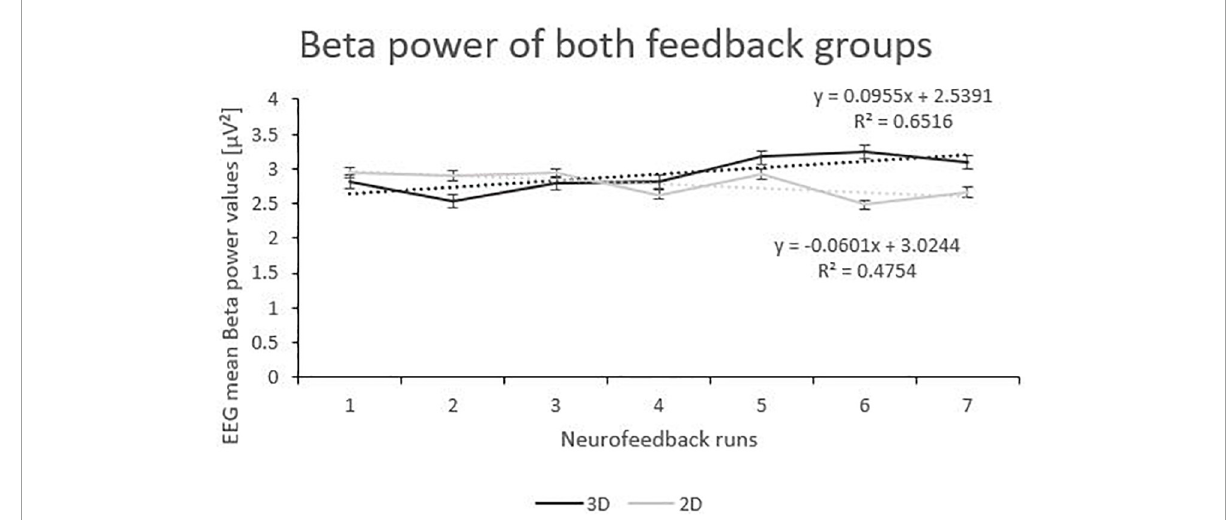
FIGURE4 Trend of Beta Power over the Feedback Runs for 3D and 2D Groups with the linear trendlines of each group. R 2 represents the respective explained variance of Beta power. Error bars show Standard